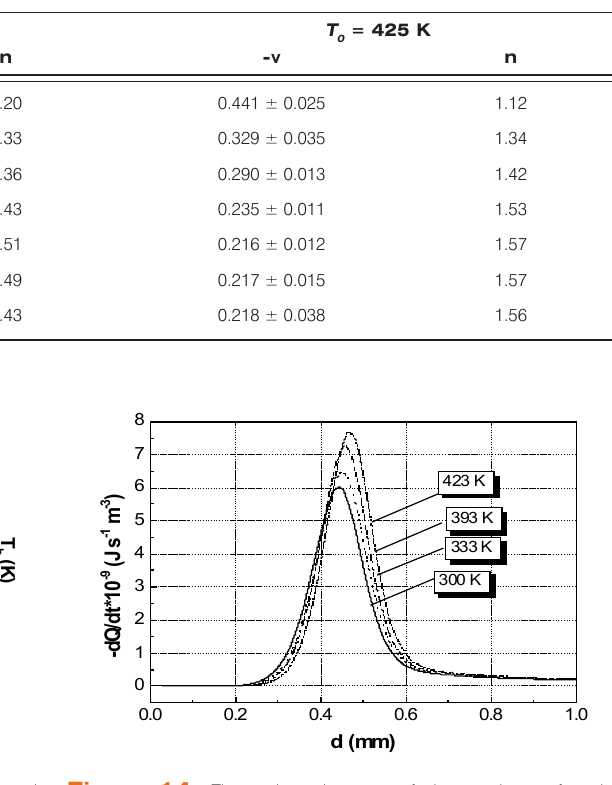
Figure 14. The volumetric rate of heat release for the stoichiometric C H -air mixture, at p = 1 bar and 0 2 6 H -air mixture, at various initial 2 6